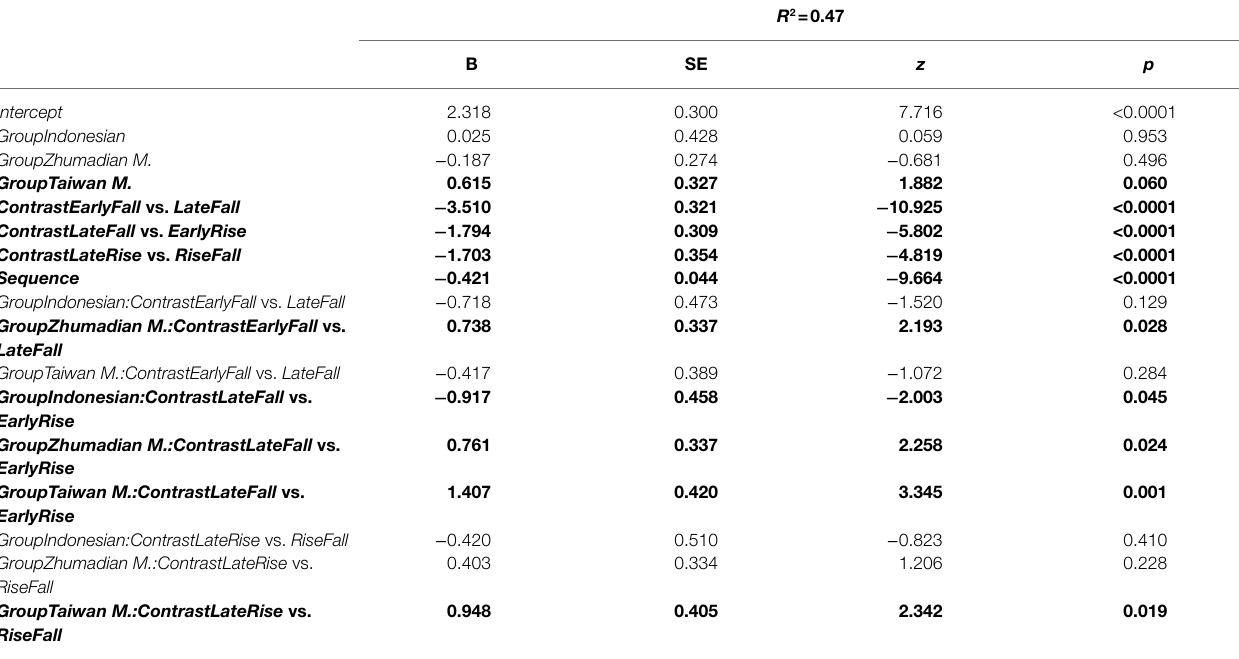
TABLE 7 | Results of mixed-effects logistic regression analysis with Swedish and [la] vs. [ta] as baselines.